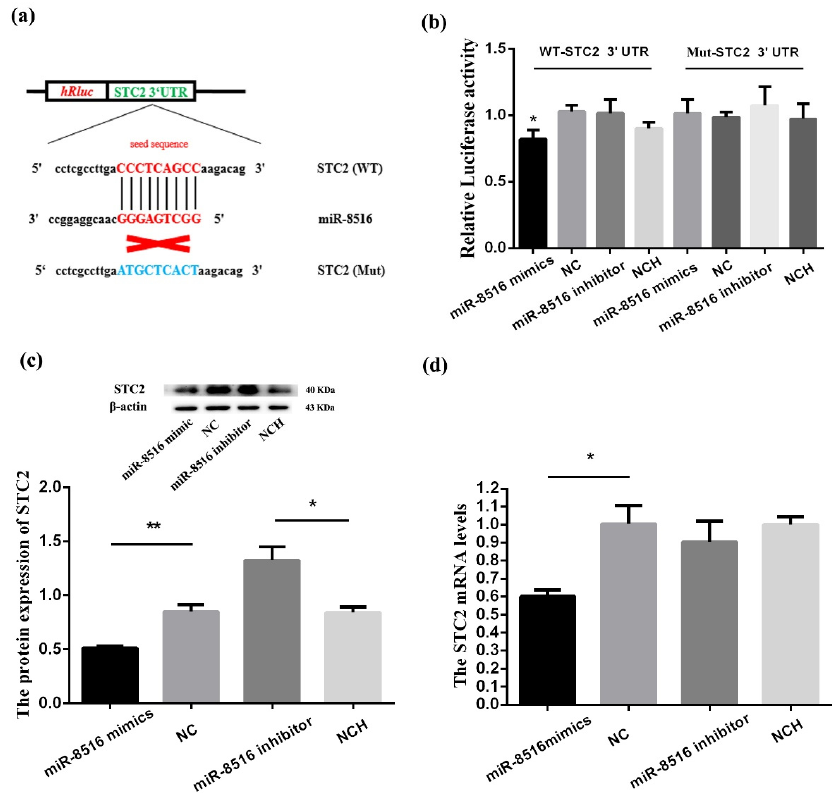
Figure 1. MiR-8516 down-regulated the expression level of STC2 via the 3 ′ UTR. ( a ) The seed sequence of miR-8516 could match with WT-STC2-3 ′ UTR and could not match with Mut-STC2- 3 ′ UTR. ( b ) Luciferase reporter assay of 293T cells co-transfected with WT-STC2-3 ′ UTR or Mut- STC2-3 ′ UTR and miR-8516 mimic, NC (negative control), miR-8516 inhibitor or NCH (NC- inhibitor). ( c ) miR-8516 decreased STC2 protein level in GMECs. ( d ) miR-8516 decreased STC2 mRNA level in GMECs.